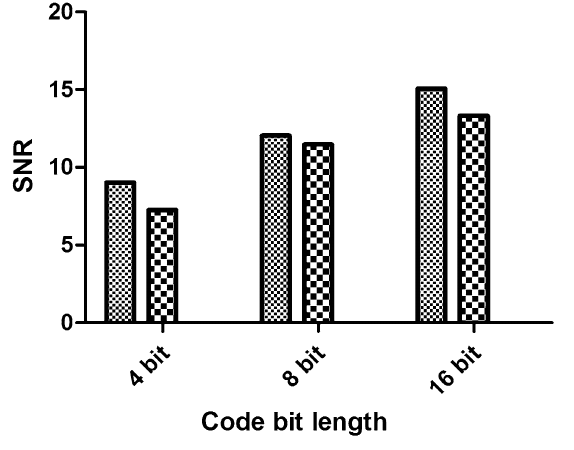
Figure 3. SNR improvement of the echo signal under Golay code excitations.